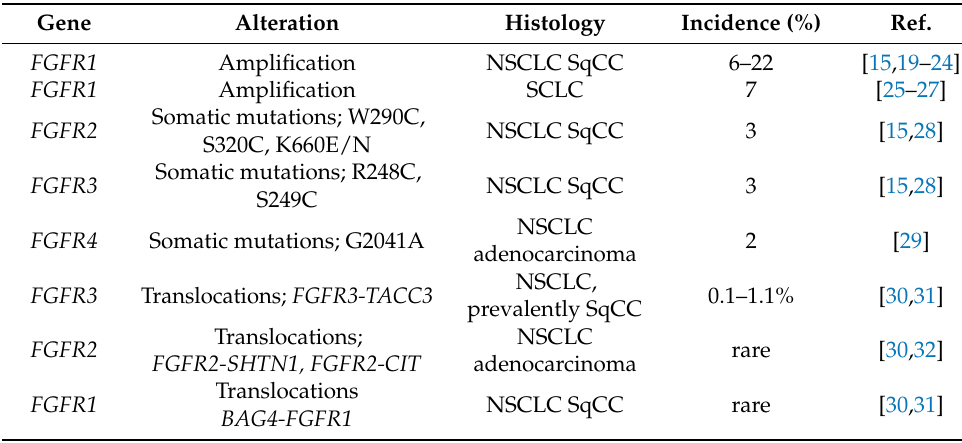
Table 1. Common FGFR genomic alterations found in lung